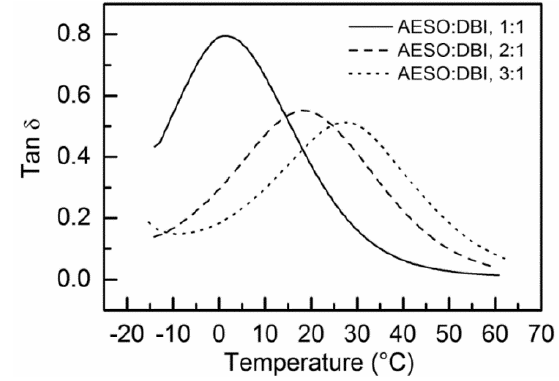
Figure 7. Tan δ as a function of temperature for AESO-DBI thermosets.